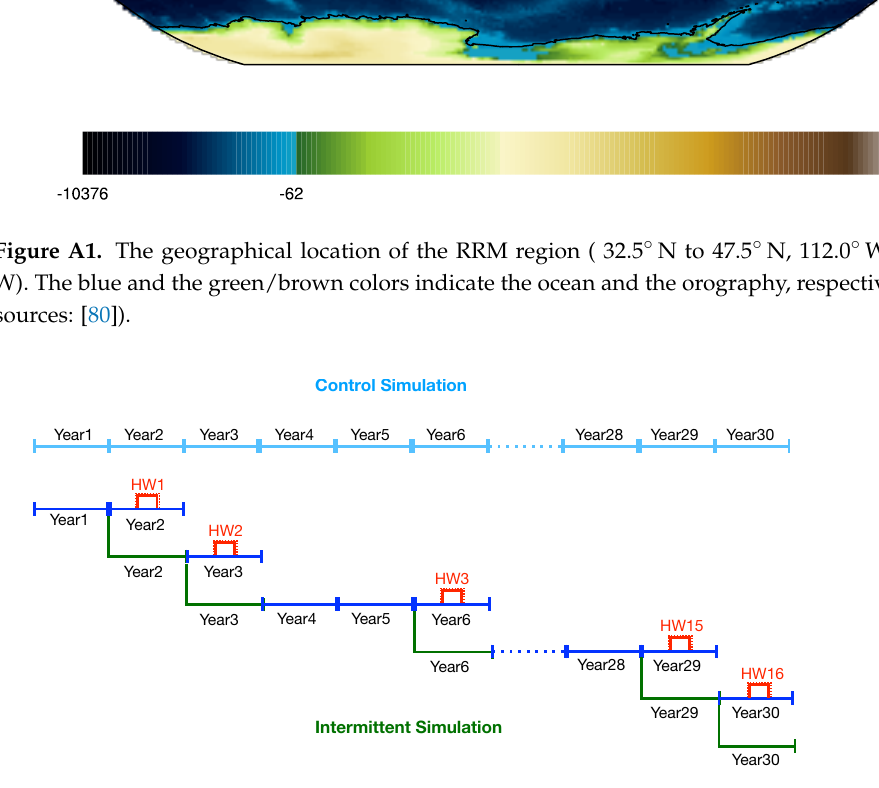
Figure A2. Schematic representations of the control and intermittent simulations. The long-term consequences of HW suppression is estimated from the 30-year mean control and intermittent simulation. The light blue lines indicate control simulation, dark blue lines indicate year without HWs, dark blue lines with red peaks indicate year with HWs and the green lines indicate year with HW suppression. The dashed red line in the intermittent simulation represents the ensemble